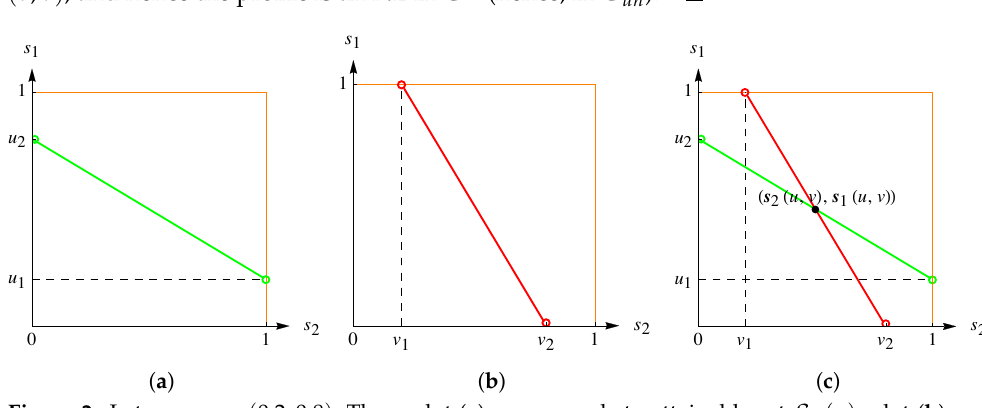
Figure 2. Let u = v = ( 0.2,0.8 ) . Then, plot ( a ) corresponds to attainable set S II ( u ) ; plot ( b ) cor- responds to S I ( v ) . Plot ( c ) depicts the corresponding stationary distribution ( s 1 ( u , v ) , s 2 ( u , v )) = ( 1/2,1/2 ) as the intersection of the attainable